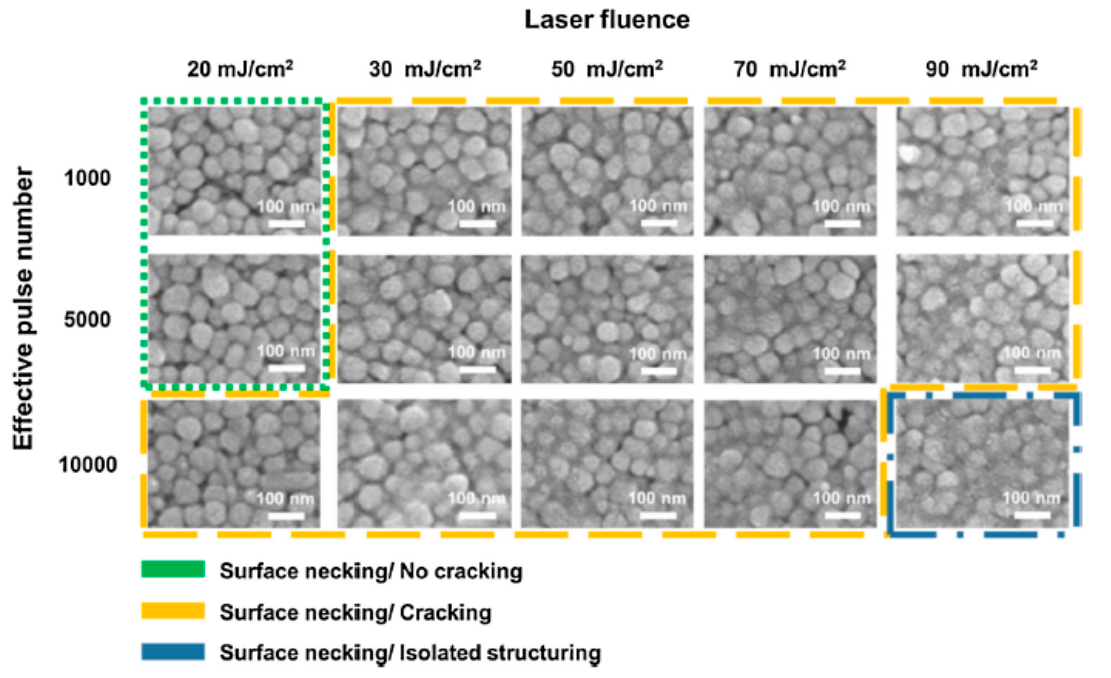
Figure 19. SEM images of fs Ag NPs sintered at various laser fluences (Adapted from reference [173]).